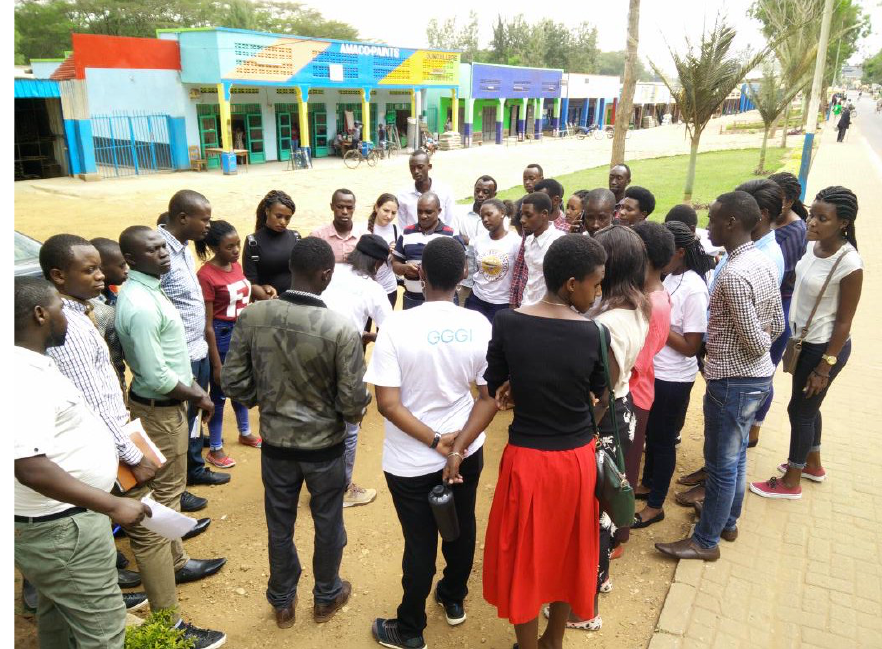
Figure 1. Urban Walk in Nyagatare. The District’s Executive Secretary joined citizens in exploring green areas in the urban core, in October